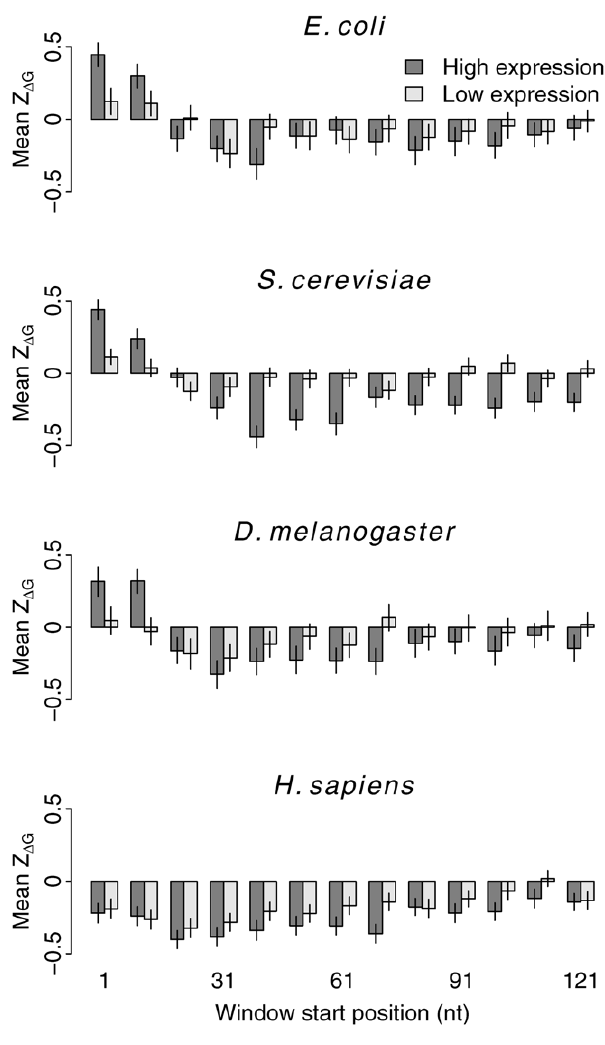
Figure 6. Comparison of the mean 5 9 Z D G between genes with the highest 5% and the lowest 5% expression level in E.coli , S. cerevisiae , D.melanogaster , and H.sapiens .